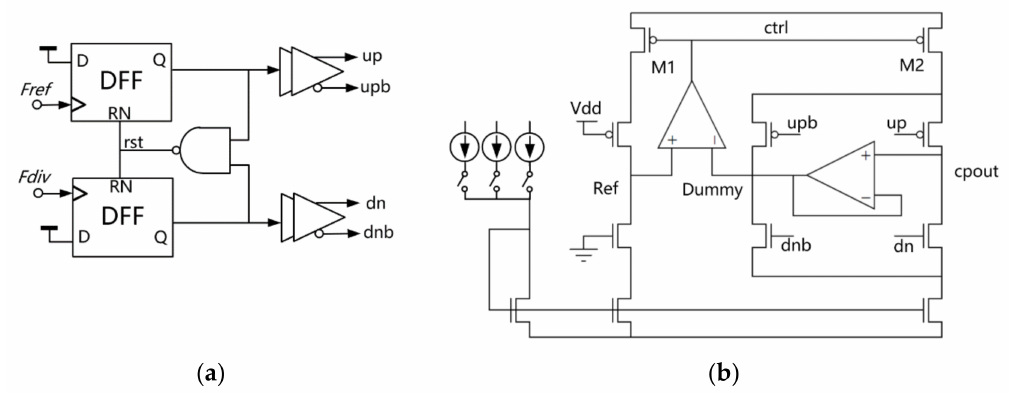
Figure 4. Schematic for ( a ) the phase-frequency detector; ( b ) the charge pump with dual Op-amp design for matching up and down